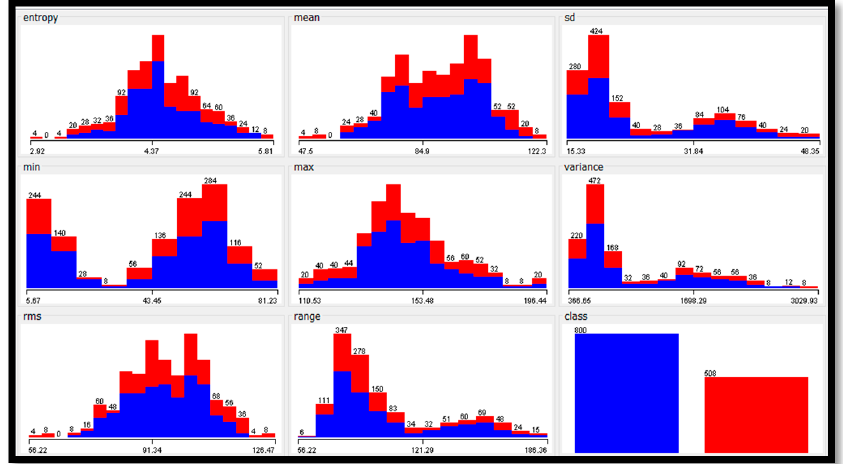
Figure 9. The histograms of features values of the combination of the MIAS and digital mammography dream challenge datasets.